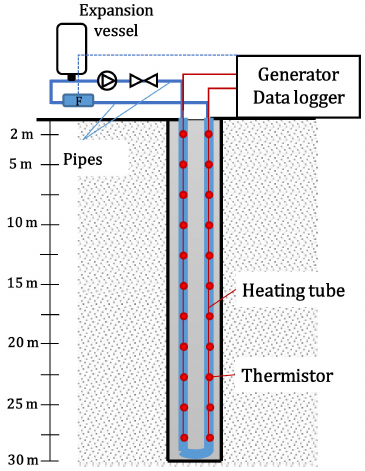
Figure 6. Schematization of the standard routine